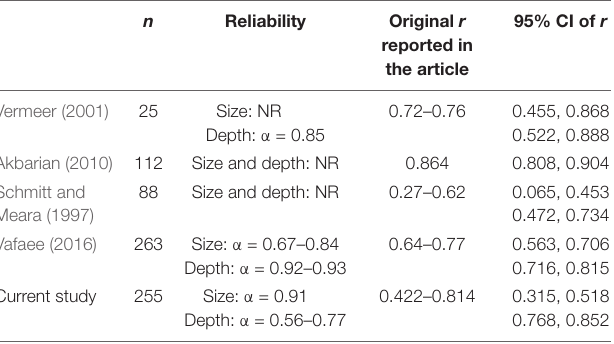
TABLE 6 | Reliability and confidence intervals of correlation coefficients between size and depth in previous studies. n